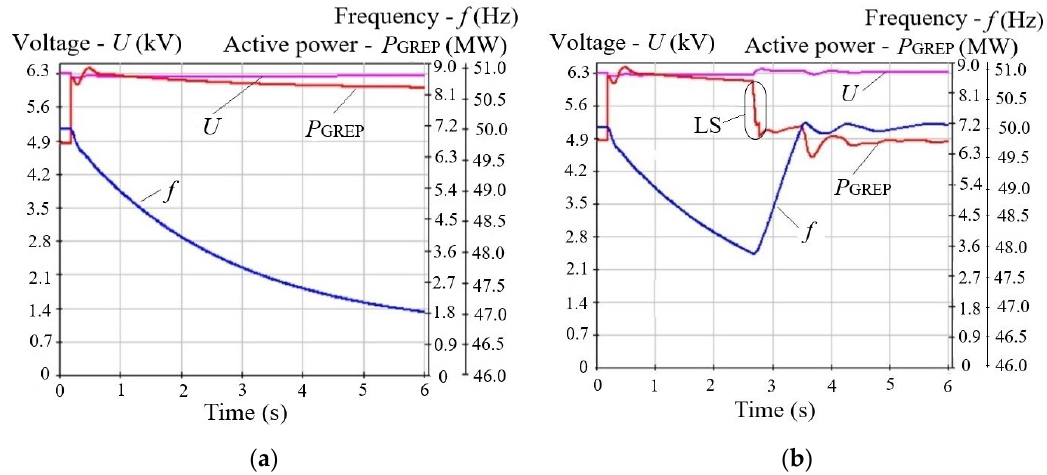
Figure 2. Transients in the event of shutting down one of the four GREPs: ( a )—without applying the LS CA; ( b )—with the action of SALSS ( P GREP —power of 3 operating GREPs).